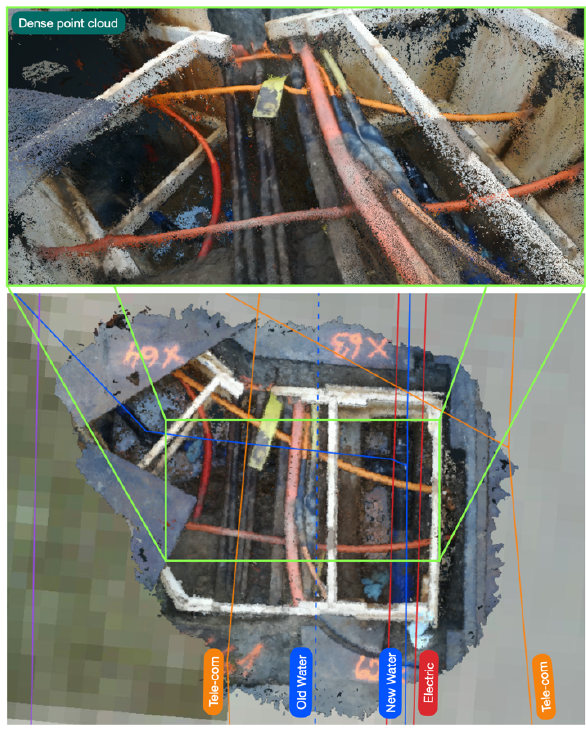
Figure 5. A similar comparison between existing GIS utility records and as-is excavation hole point cloud seen from above.